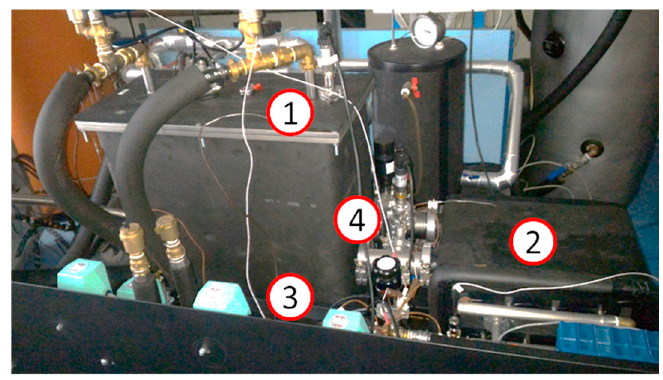
Figure 11. The TES prototype system realized at CNR-ITAE. 1: Adsorber, 2: Phase changer, 3: Hydraulics. 4: Vacuum valve.